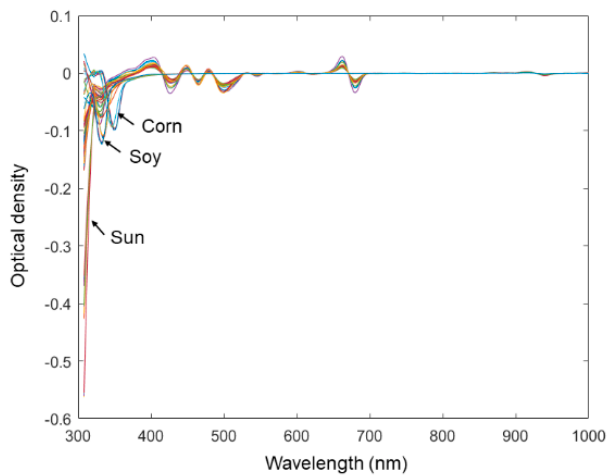
Figure 6. Spectra of multiplicative scatter correction followed by the first-level derivative (MSC-Der1) pretreated data of extra virgin olive oils and other vegetable oils.